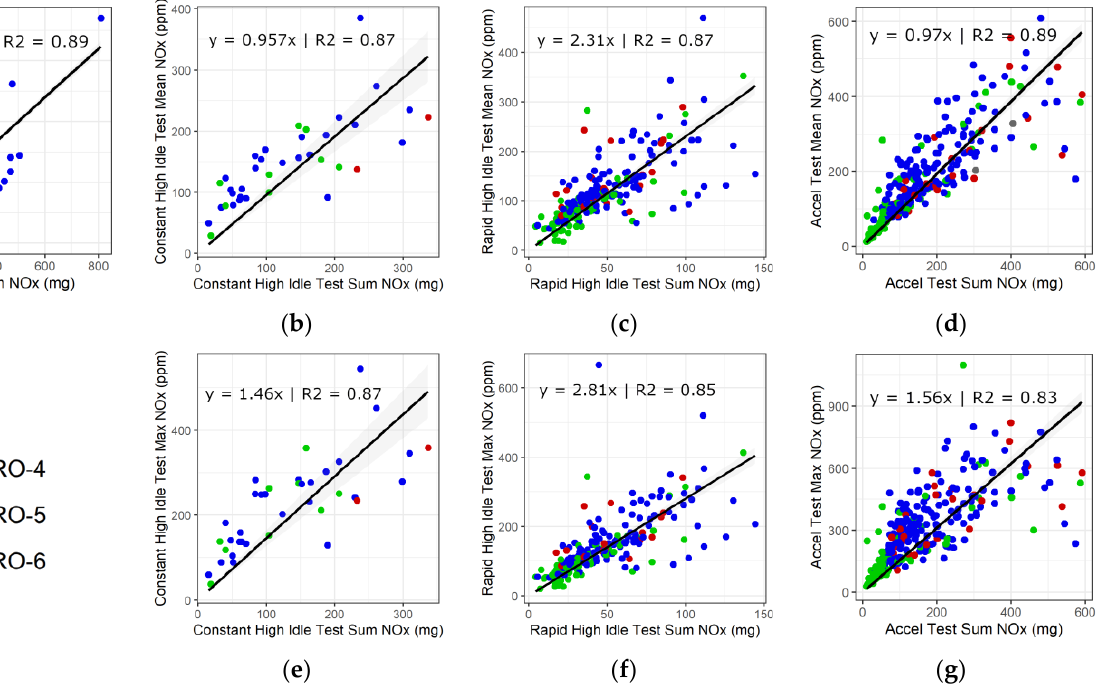
Figure 2. Diesel vehicle mean and maximum NOx concentration vs. total mass emissions over each test section: ( a ) idle test mean NOx; ( b ) constant high idle test mean NOx; ( c ) rapid high idle test mean NOx; ( d ) acceleration test mean NOx; ( e ) constant high idle test maximum NOx; ( f ) rapid high idle test maximum NOx; ( g ) acceleration test maximum NOx.